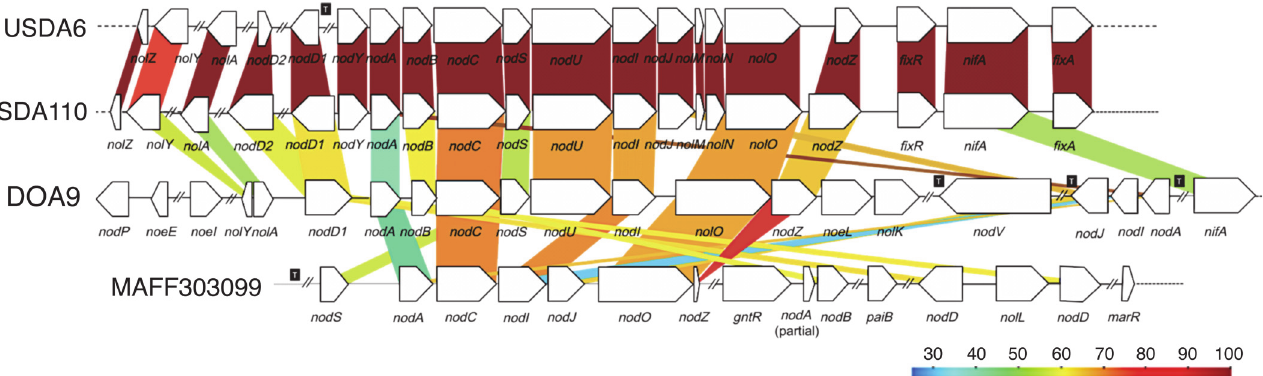
Fig 6. Comparison of nodulation gene clusters in Bradyrhizobium sp. DOA9 and related bacteria. Double slash marks represent DNA regions that are not shown. Colored strips represent the conserved gene regions between the compared strains, and the color indicates the percentage similarity, as detailed in the key. T: region where the transposase genes were located.